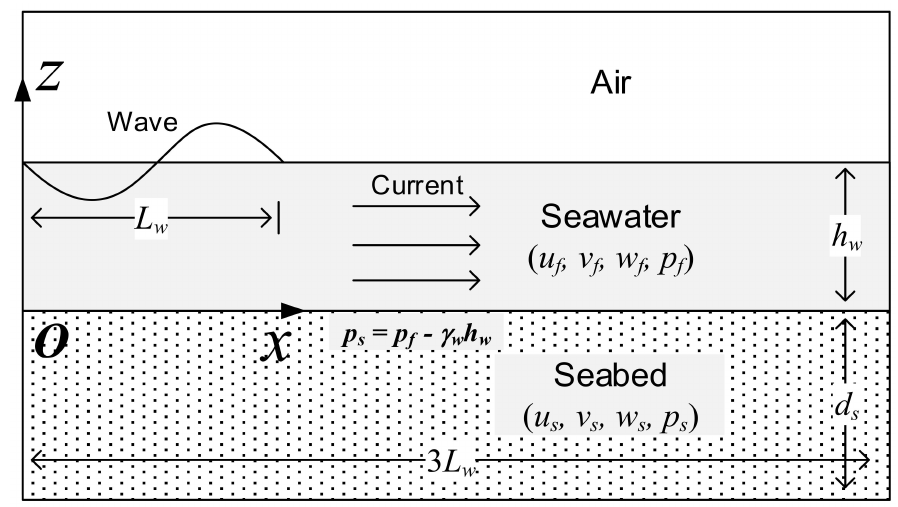
Figure 1. Definition of wave–current–seabed